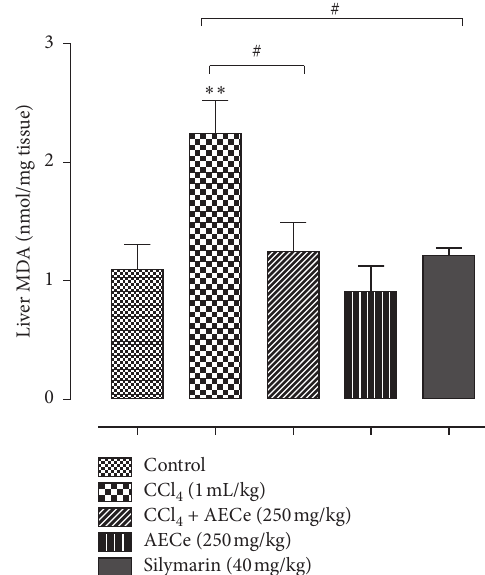
Figure 3: Effect of AECe (250 mg/kg) on lipid peroxidation in the liver of rats with CCl 4 -induced liver damage. The values represent the mean ± SEM, with n � 6. ∗∗ p < 0 . 01 vs. control group; # p < 0 . 05 vs. CCl 4 Table 3, no significant differences in creatinine, urea, and uric acid levels were detected in the CCl compared with the normal control group.